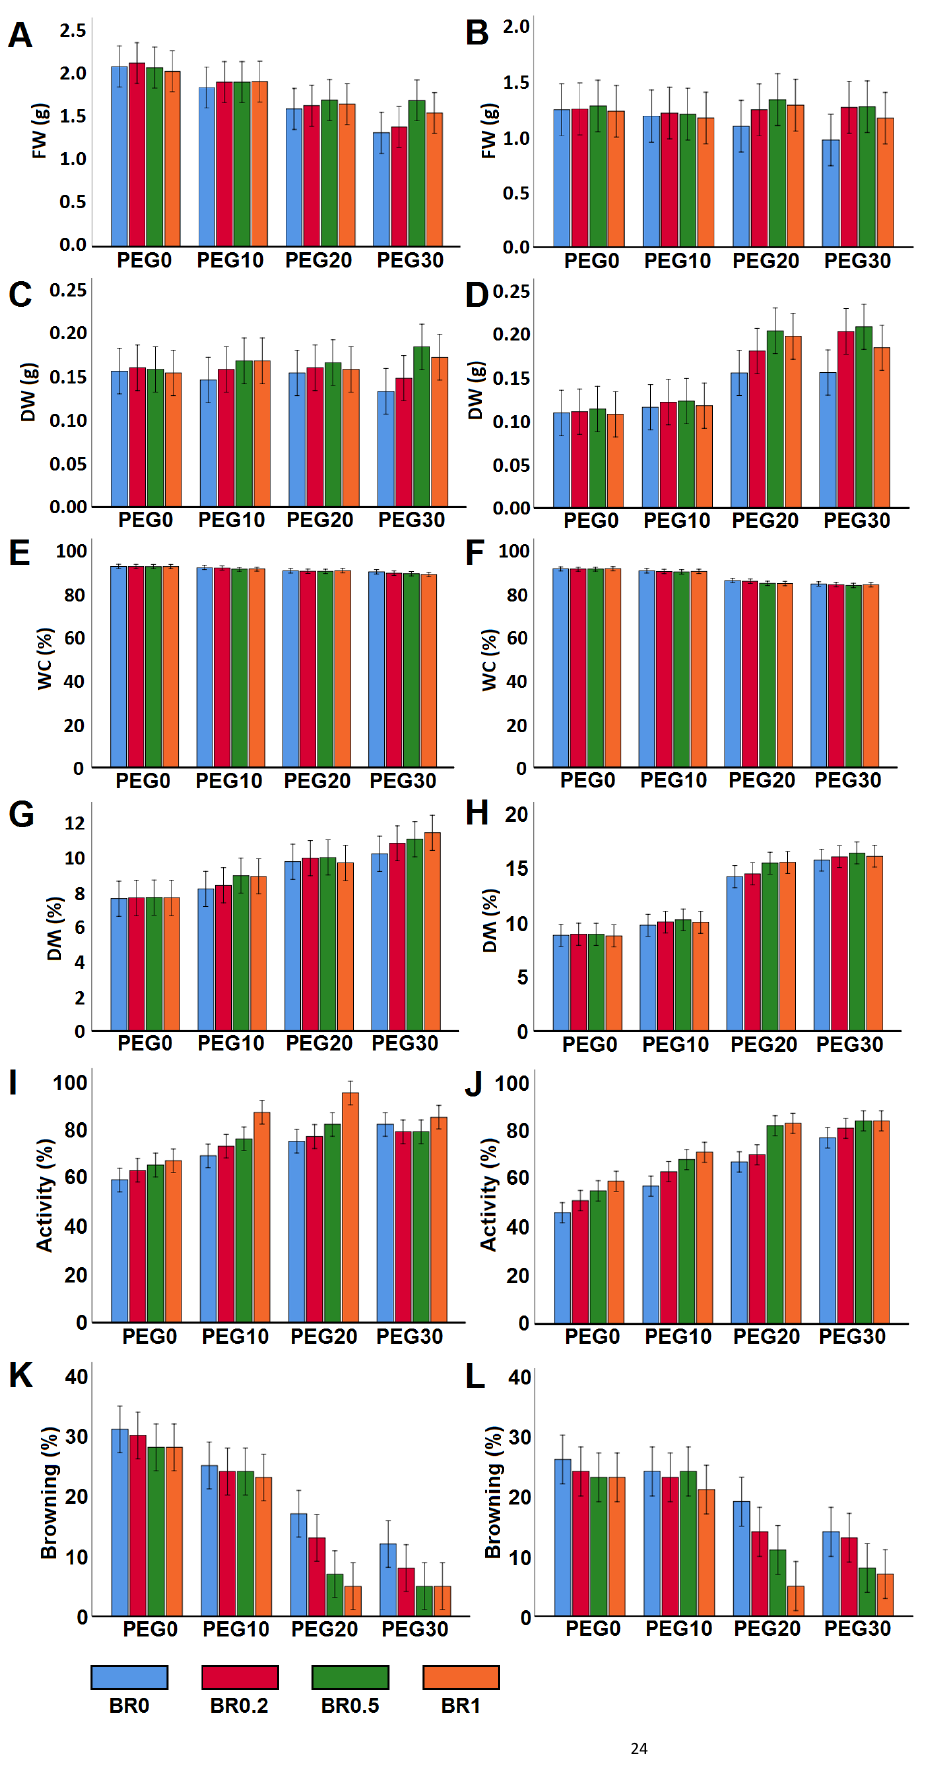
Figure 1. The effect of polyethylene glycol and (A brassinosteroid treatment on the and B) (C tissue fresh weight [FW (g)] and D) , dry weight [DW (g)] (E and F) , water content [WC (%)] (G and H) (I , dry matter content [DM and J) (K and (%)] , activity (%) L) , and browning (%) (A, C, E, G, I, and K) of cultured ‘Barhi’ date palm (B, D, F, H, J, and L) callus and embryos . PEG0, PEG10, PEG20, and PEG30 refer to culture medium content of polyethylene glycol (0, 10, 20, and 30 g.L-1, respectively), while BR0, BR0.2, BR0.5, and BR1 refer to culture medium content of brassinosteroid (0, 0.2, 0.5, and 1 µM, respectively). The values in the charts represent means, and error bars represent standard errors. LSDp≤0.01 is 0.36, 0.51, 0.03, 0.06, 1.8, 2, 1.8, 2, 9.2, 7.9, 7.3, and 7.6, for A to L,